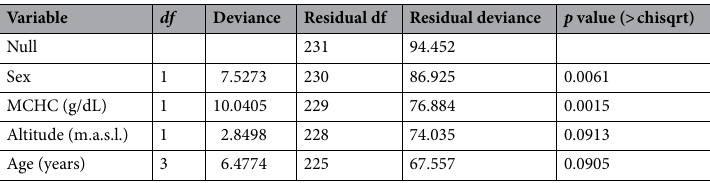
Table 1. Analysis of deviance for the GLM model